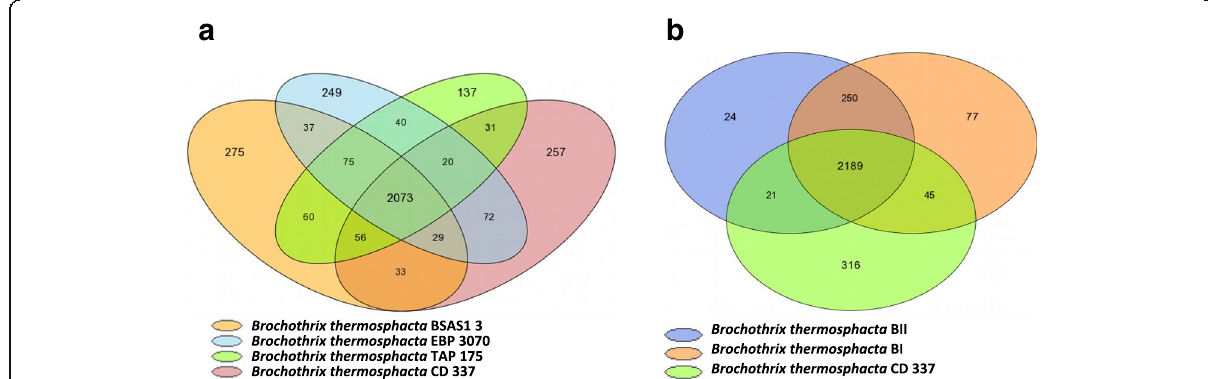
Fig. 4 Core and pan genomes. Venn diagram analysis of ( a ) Brochothrix thermosphacta CD 337, B. thermosphacta TAP 175, B. thermosphacta BASA1 3, and B. thermosphacta EBP 3070; and ( b ) B. thermosphacta CD 337, B. thermosphacta BI, and B. thermosphacta BII. Values on diagram represent the numbers of MICFAM families for each organism